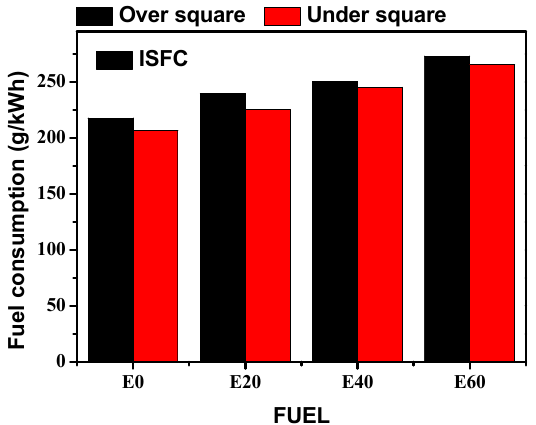
Figure 10. Fuel consumption for over- and under-square engine and ethanol blending ratio.